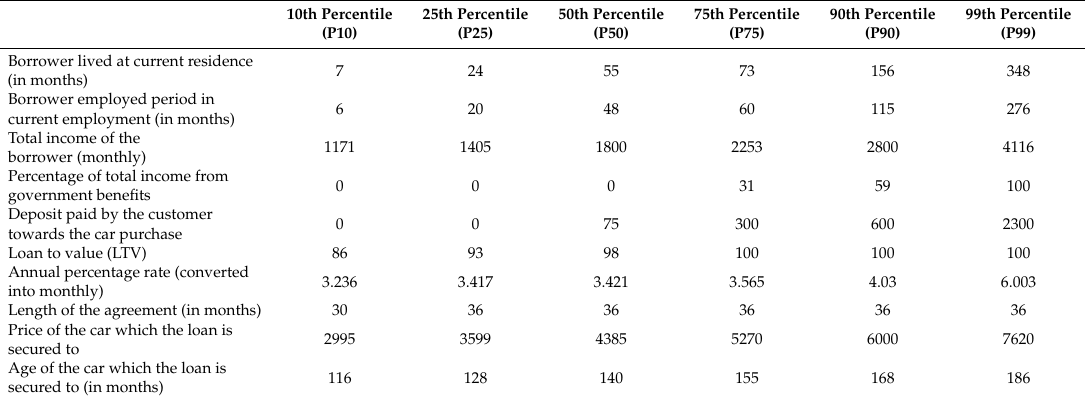
Table 2. Salient feature of subprime borrowers, loans, and asset financed (automobile). 10th Percentile